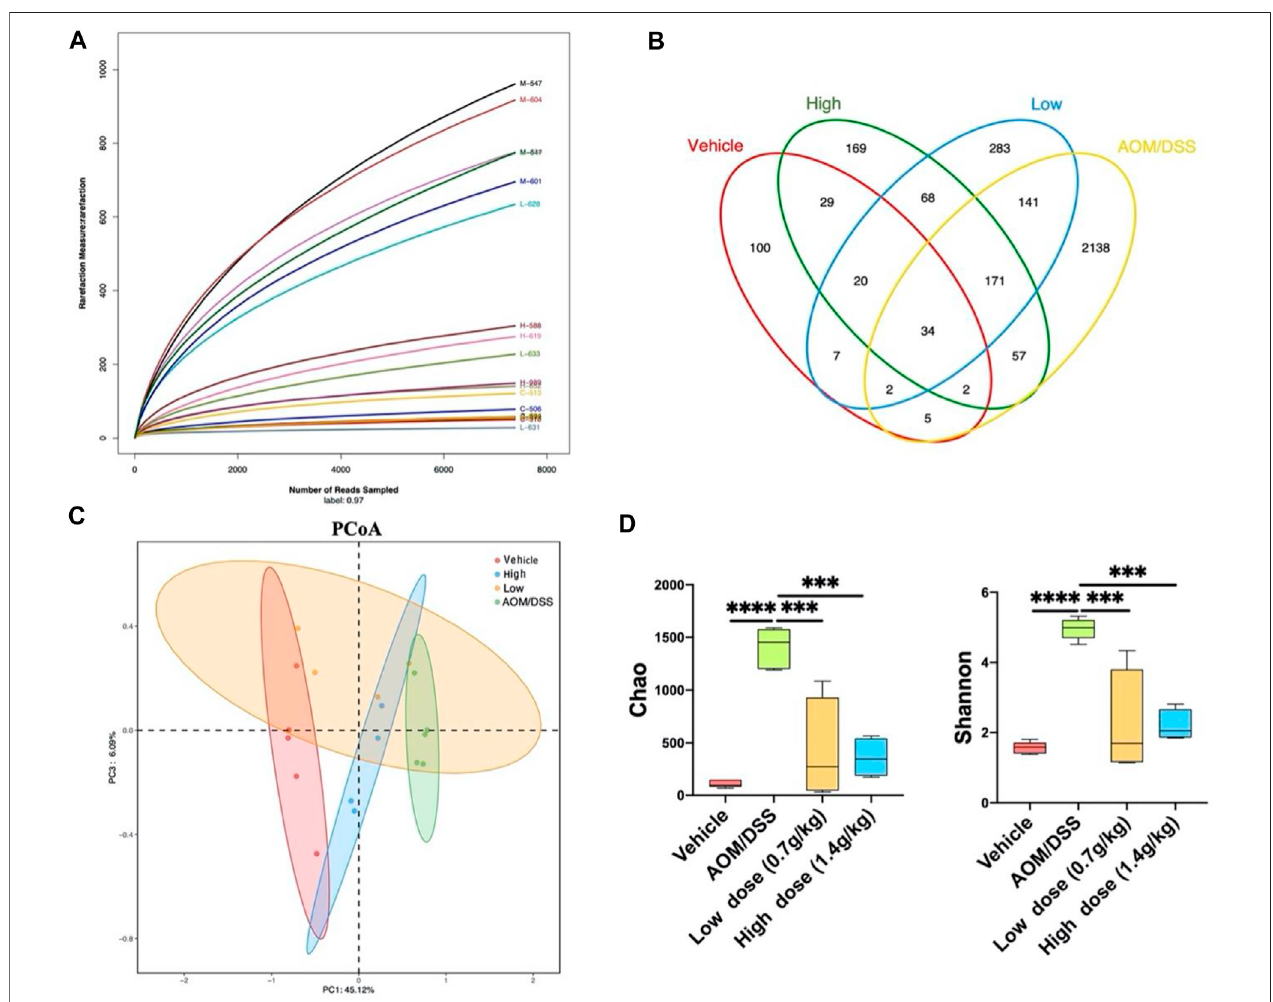
FIGURE 2 | QCWZD can change the structure of intestinal microbiota in AOM/DSS mice. (A) Rarefaction curves determined at the 97% similarity level. (B) Venn diagram of OTUs in the four groups (vehicle group, AOM/DSS group, low-dose group, high-dose group). (C) Multiple-sample PCoA analysis. (D) Chao and Shannon indices. Low dose: 0.7 g/kg, High dose: 1.4 g/kg *** p < 0.001, **** p < 0.0001.